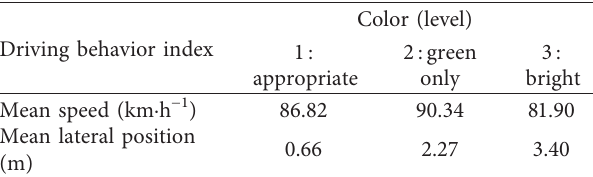
Table 3: Driving behavior index results under various levels of height factor.